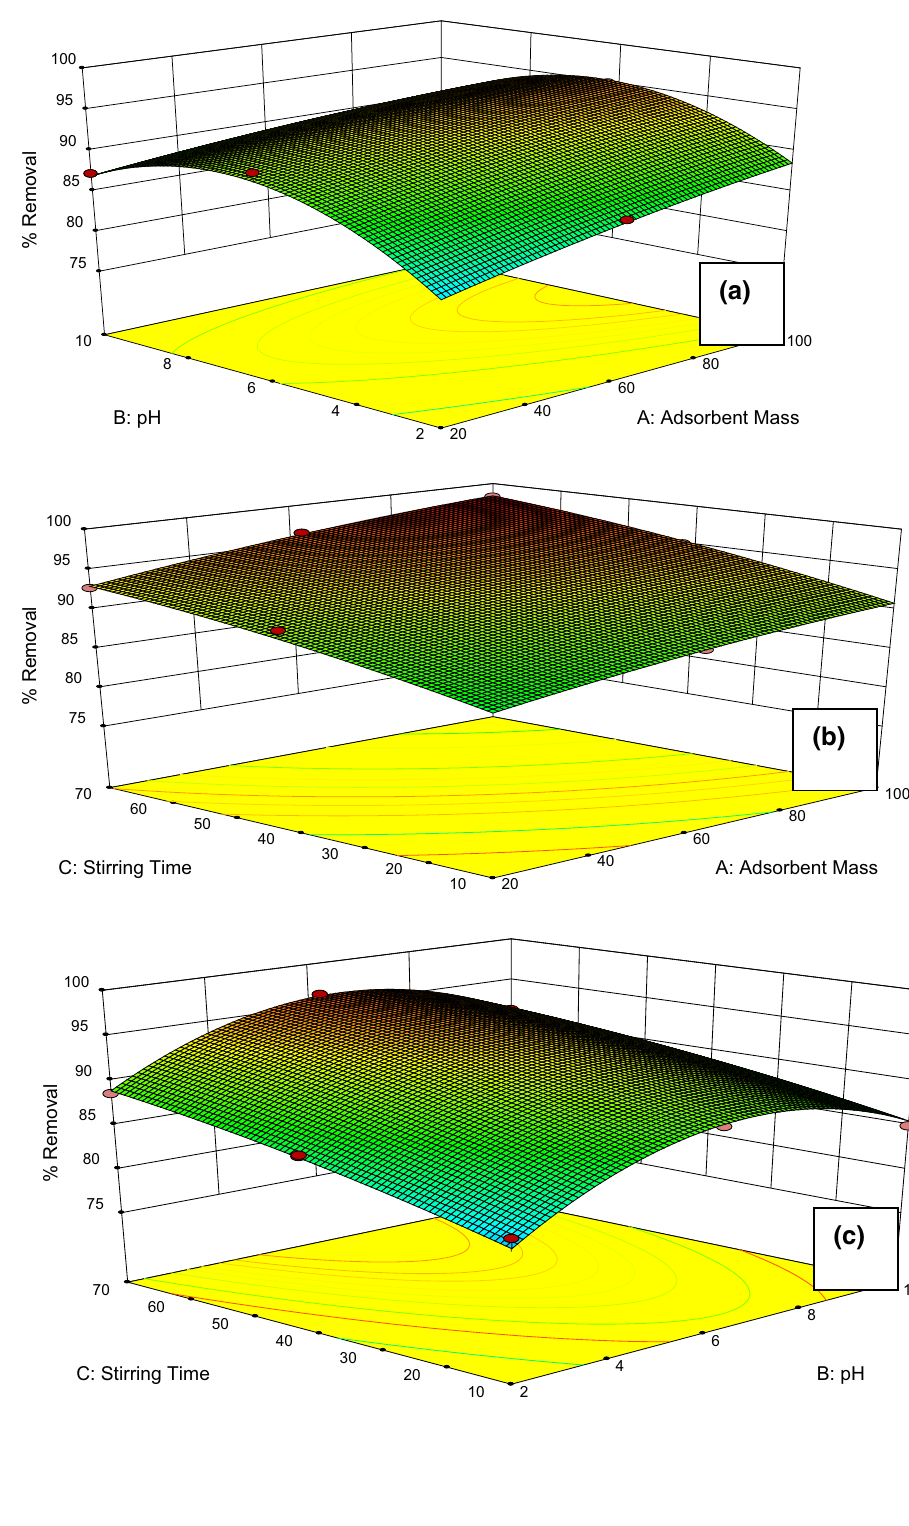
Fig. 15 Response surface plots of the effects of a pH vs adsor- bent dosage, b contact time vs adsorbent dosage, c contact time vs pH for Pb(II) removal using